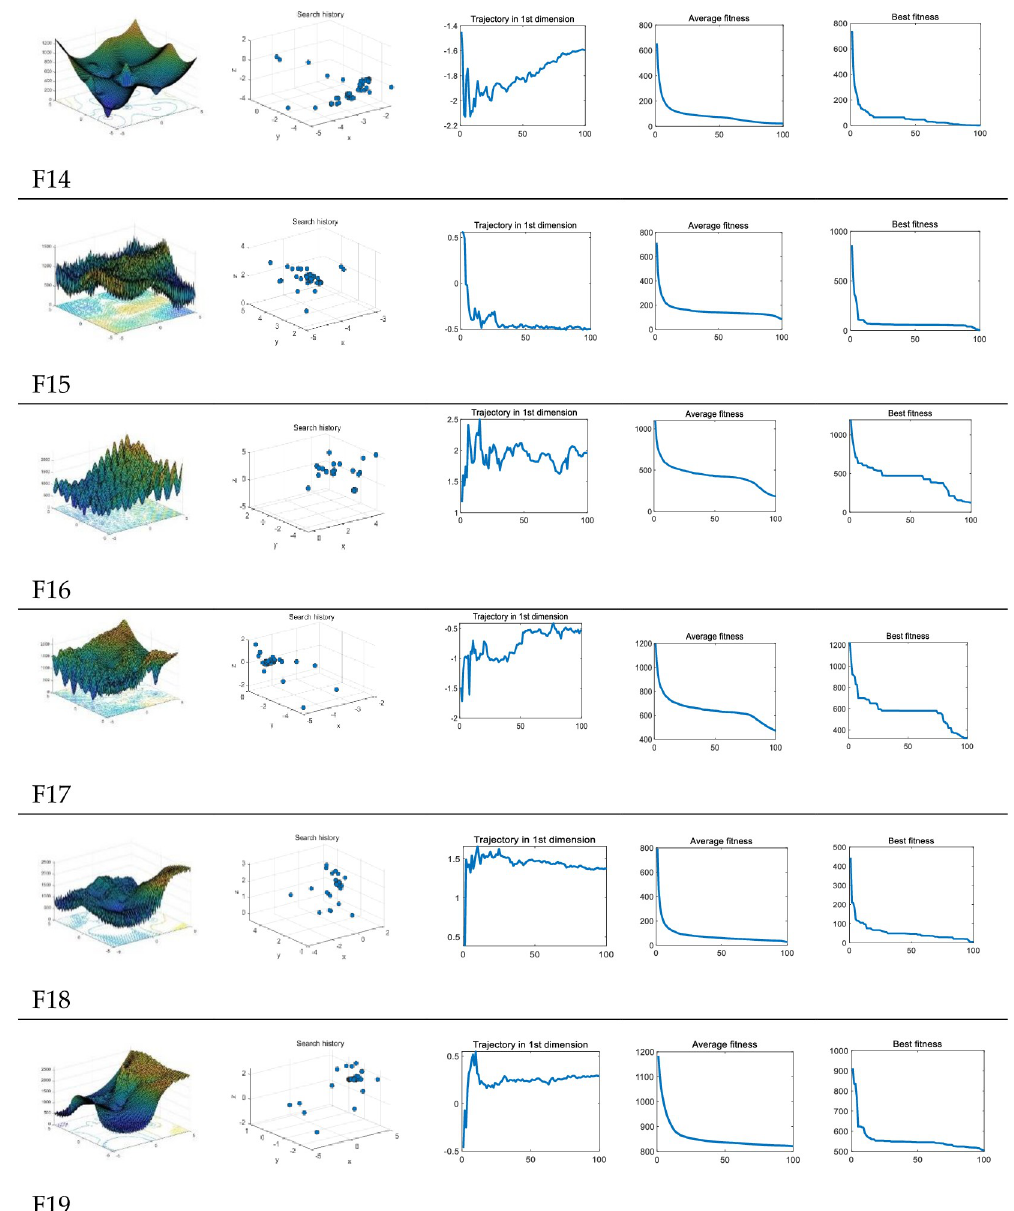
Fig 7. MSA search history of composite benchmark